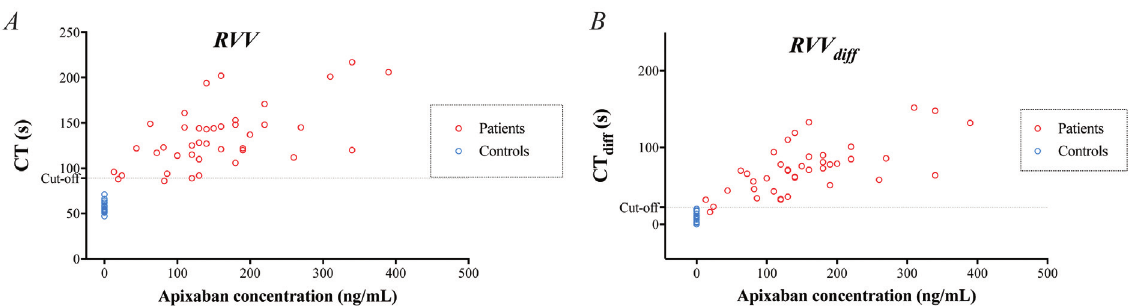
Fig. 6 Rotational thromboelastometry (ROTEM) analyses using the Russell viper venom (RVV) trigger – variables clotting time (CT) ( A ) and CT diff ( B ; the difference in CT without vs. with DOAC-Stop [DS]) – performed on blood samples from 40 patients on apixaban treatment. Variables presented in relation to apixaban concentration measured by liquid chromatography with tandem mass spectrometry (LC-MS/MS). Cutoff line represents optimal receiver operating characteristics (ROCs) for discriminating between samples with apixaban concentration above or below 20ng/mL.